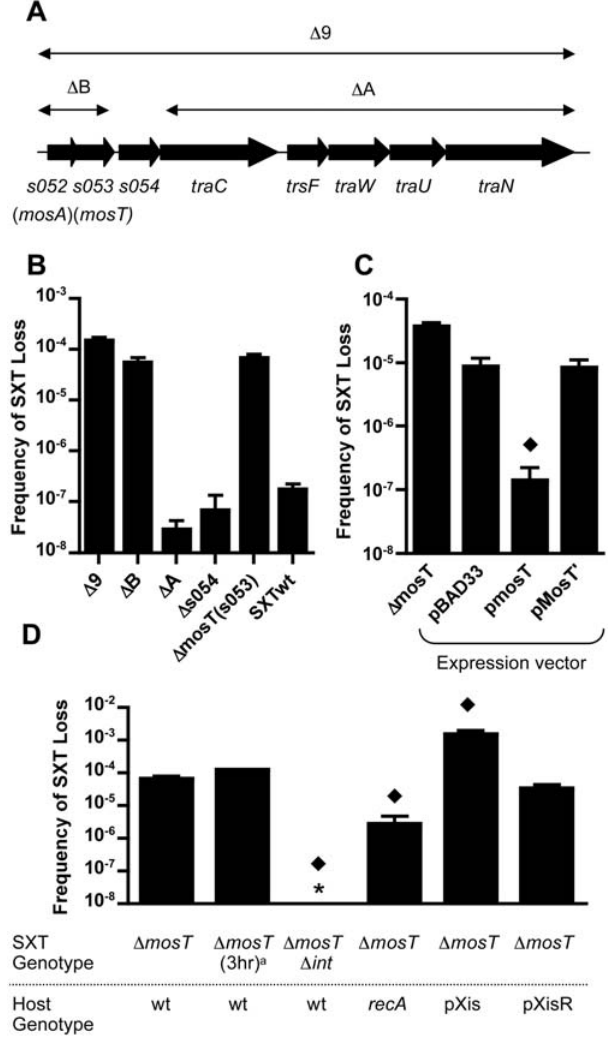
Figure 3. Genetic analysis of loss of mosT SXT. A) Schematic of the region deleted from D 9 SXT. Black arrows represent ORFs, thin black arrows represent the deletions studied below. B) Frequency of loss of the indicated mutant SXT. C) Influence of mosT expression in trans on the stability of mosT SXT. All cultures were grown in the presence of 0.02% arabinose for 15 hr. Black diamond represents a statistically significant (p , .05) result compared to loss in the presence of pBAD33. D) Loss of mosT SXT is influenced by factors affecting SXT excision. All cultures were grown for 15 hr except as noted. Black diamonds represent a statistically significant (p , 0.05) result compared to the mosT SXT grown for 15 hr. The * signifies that the result was below the limit of detection which was , 1 6 10 2 8 . a Loss was calculated